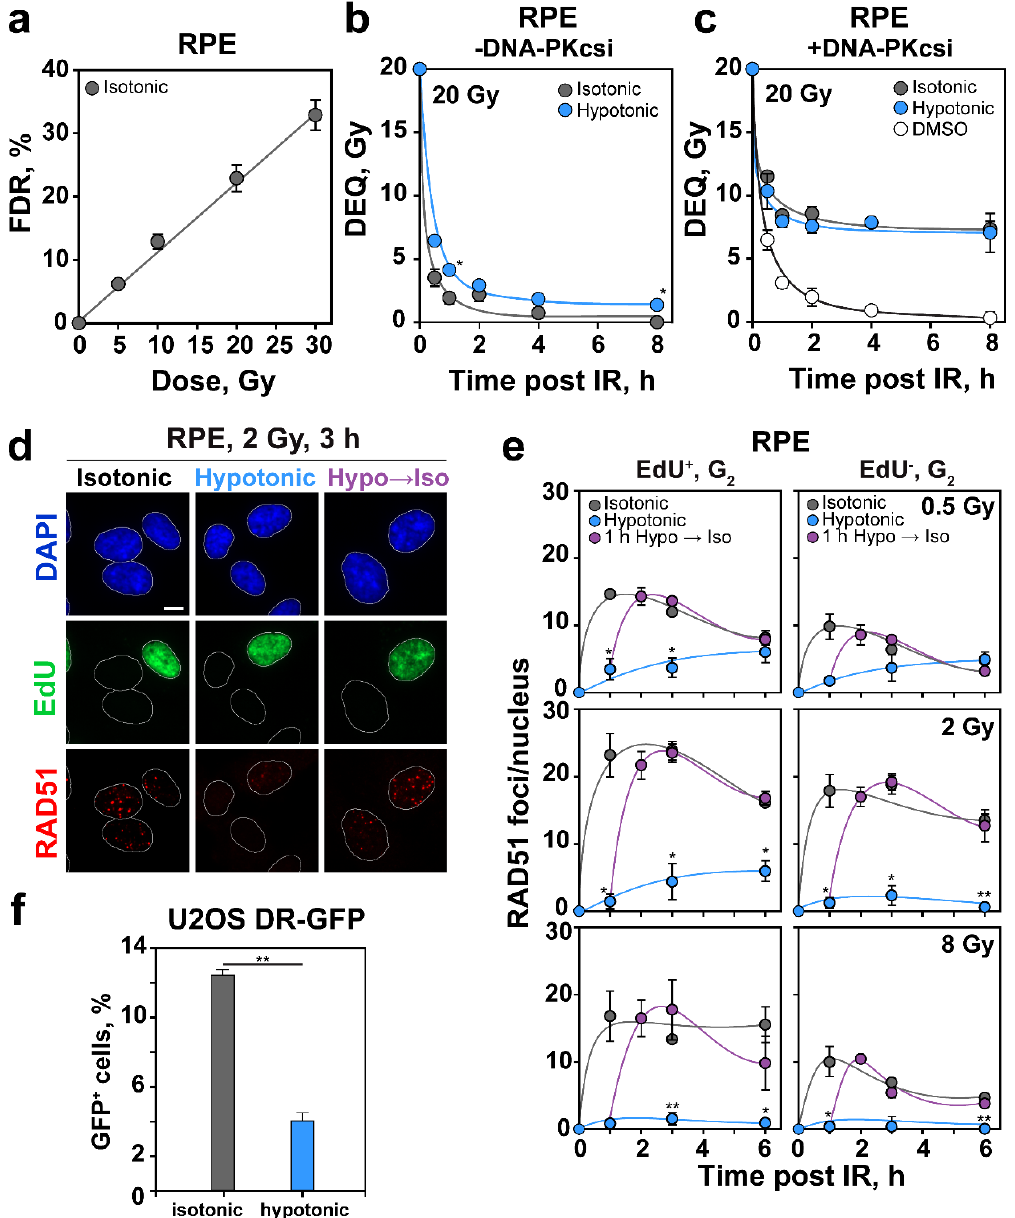
Figure 5. HypoS strongly suppresses HR and causes modest inhibition on c-NHEJ and alt-EJ. ( a ) Dose-response for DSB induction measured by PFGE in RPE cells. The fraction of DNA released (FDR) from the well into the lane is plotted against the IR dose applied. ( b ) Cells were exposed to 20 Gy prior to incubation in isotonic or hypotonic medium. The equivalent dose (DEQ) was calculated using the corresponding dose response curve from the FDR measured at each time point. ( c ) As in ( b ) for cells treated with DNA-PKcsi (5 µ M NU7441) 1 h before IR. Data in ( b , c ) represent means and SE from eight determinations in two experiments. Error bars are visible when larger than the symbols used. ( d ) Representative images of DAPI-stained nuclei showing EdU incorporation and RAD51 foci formation at 3 h post 2 Gy in isotonically, hypotonically and transiently hypotonically (1 h) treated cells. Scale bar: 5 µ m. ( e ) Kinetics of RAD51 foci formation after background (nonirradiated) subtraction analyzed by QIBC in EdU + and EdU − G 2 -phase cells maintained in isotonic or hypotonic medium after IR. Violet symbols show results of cells treated hypotonically for 1 h post IR before transfer to isotonic medium. ( f ) GFP positive (GFP + ) cells in the U2OS DR-GFP reporter cell line, 24 h after transfection with an I- Sce I expressing plasmid followed by incubation in hypotonic (blue bar) or isotonic (grey bar) medium. Means ± SE from two independent experiments are shown. In all plots the significance of differences between isotonic and hypotonic conditions is indicated by the asterisk: * p < 0.05 and ** p <